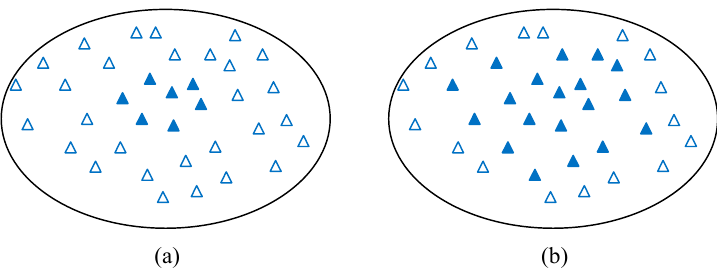
Figure 5. Intra-cell Dynamic Service Area Selection.